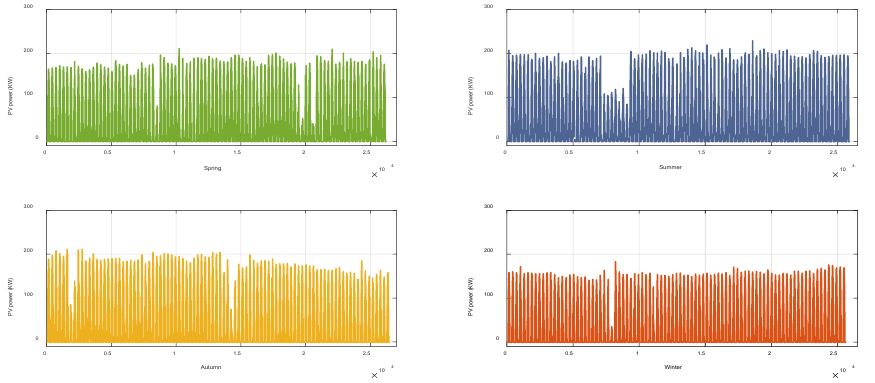
Figure 3. PV power diagram in different seasons.